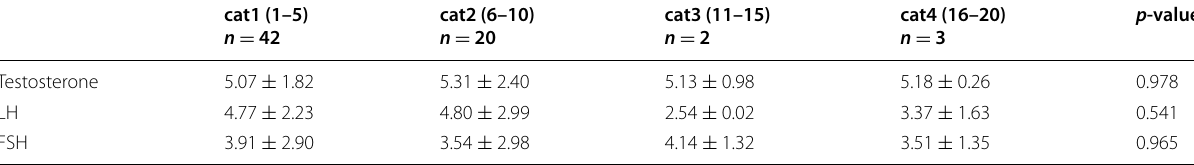
P ‑value of ANOVA test < 0.05* is statistically significant. N m IU/ml). One tablet of